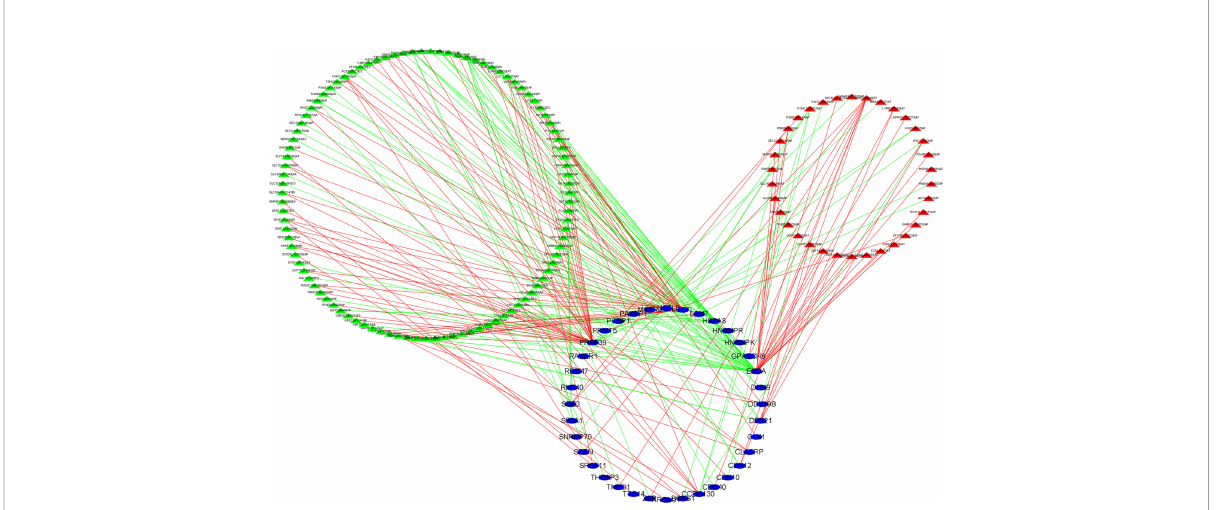
FIGURE 8 Construction of alternative splicing events and splicing factors regulatory network. Blue ellipse represents splicing factors, green/red triangle represents favorable/adverse alternative splicing events, and green/red line represents positive/negative regulation. Cor > 0.65, p <